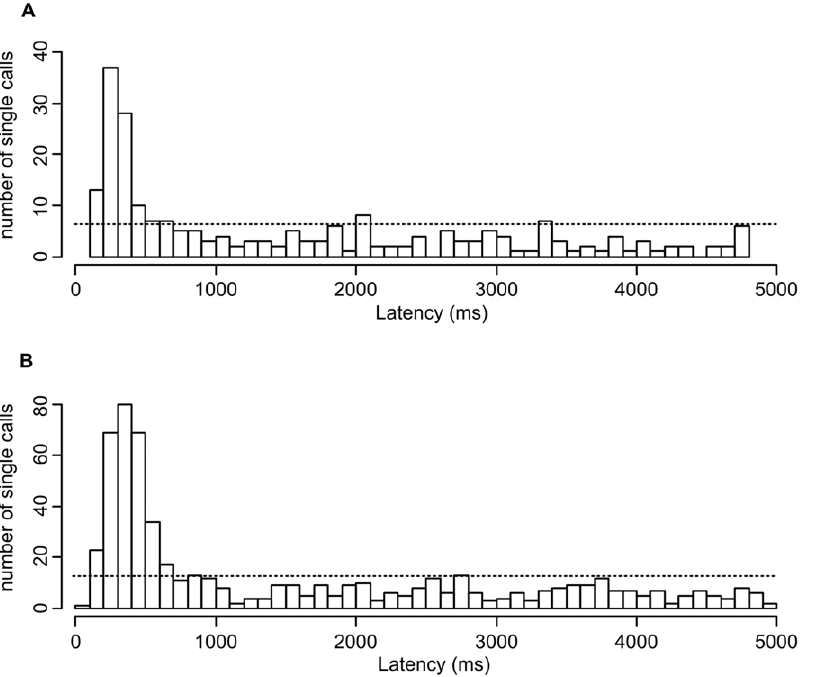
Figure 3. Histogram plots of single response calls in relation to latency of response to (A) own and (B) alien fledglings. Most responses are given shortly after the stimulus, which shows that calls are emitted in response to the stimulus. The dashed line indicates average response frequency of random response latency. Response frequencies for alien fledglings are three times higher, caused by a 1:3 ratio of own versus alien stimuli per